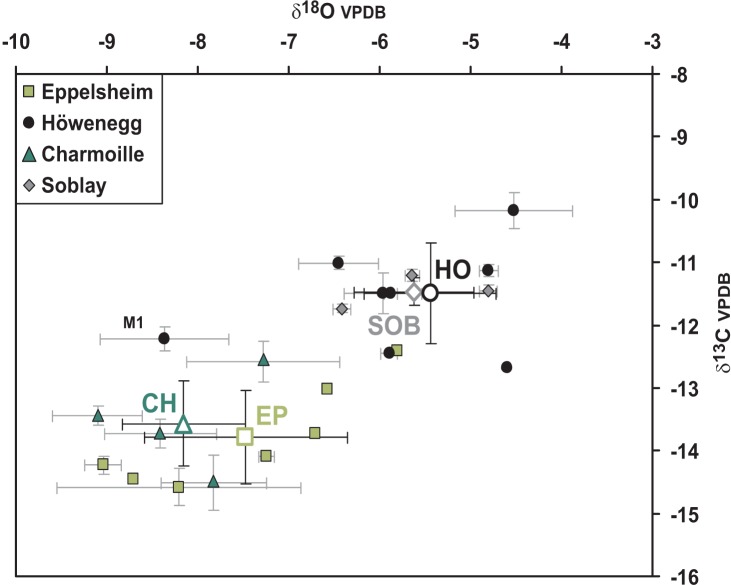
δ13C and δ18O values of all 21 H. primigenium teeth from the four different localities Eppelsheim (EP), Höwenegg (HO), Charmoille (CH) and Soblay (SOB).Note that the M1 from HO was excluded for the calculation of the HO mean value. For serially sampled teeth, average values and standard deviations are given. Mean values and standard deviations of each locality are plotted as open symbols.